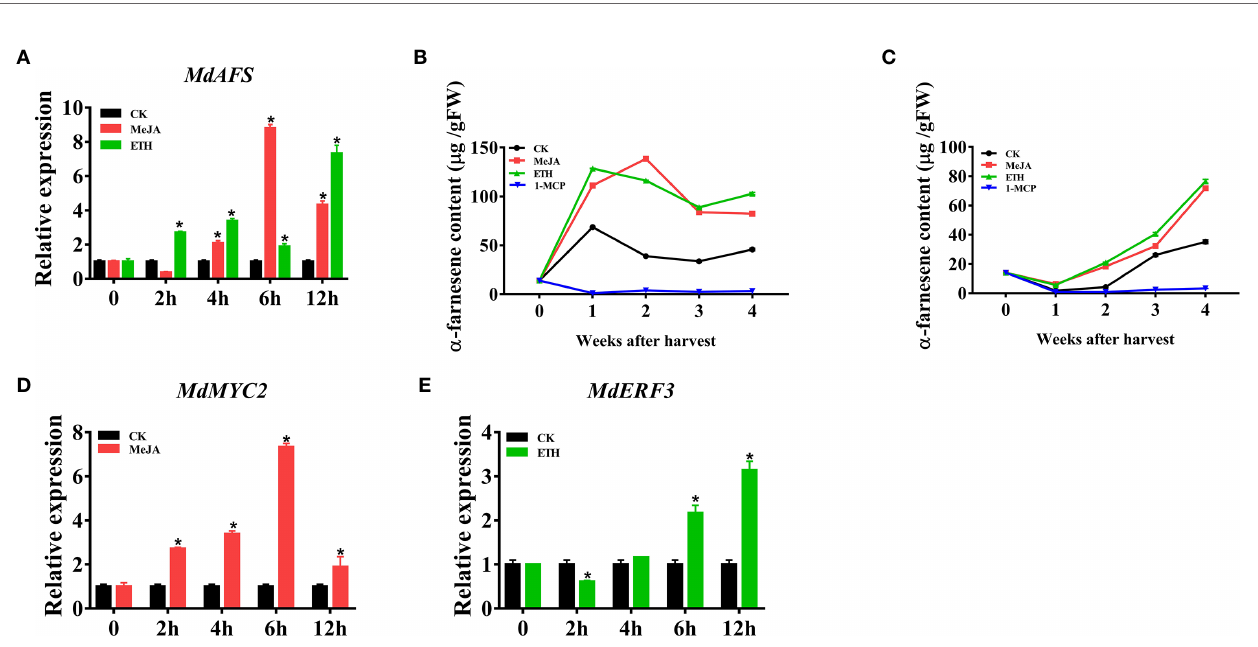
FIGURE 1 | (A) Expression of the MdAFS gene in apple leaves under MeJA and ETH treatments. (B, C) Effects of MeJA, ETH and 1-MCP on production of a -farnesene. White Winter Pearmain apples were treated with JA, ETH, and 1-MCP, and stored at room temperature and 0 ℃ for 4 weeks to detect the content of a -farnesene. (D, E) Effect of MeJA and ETH treatments on MdMYC2 and MdERF3 expression in apple leaves. Data points represent the mean values ± standard deviation of three biological replicates * indicates P < 0.05 compared to CK.